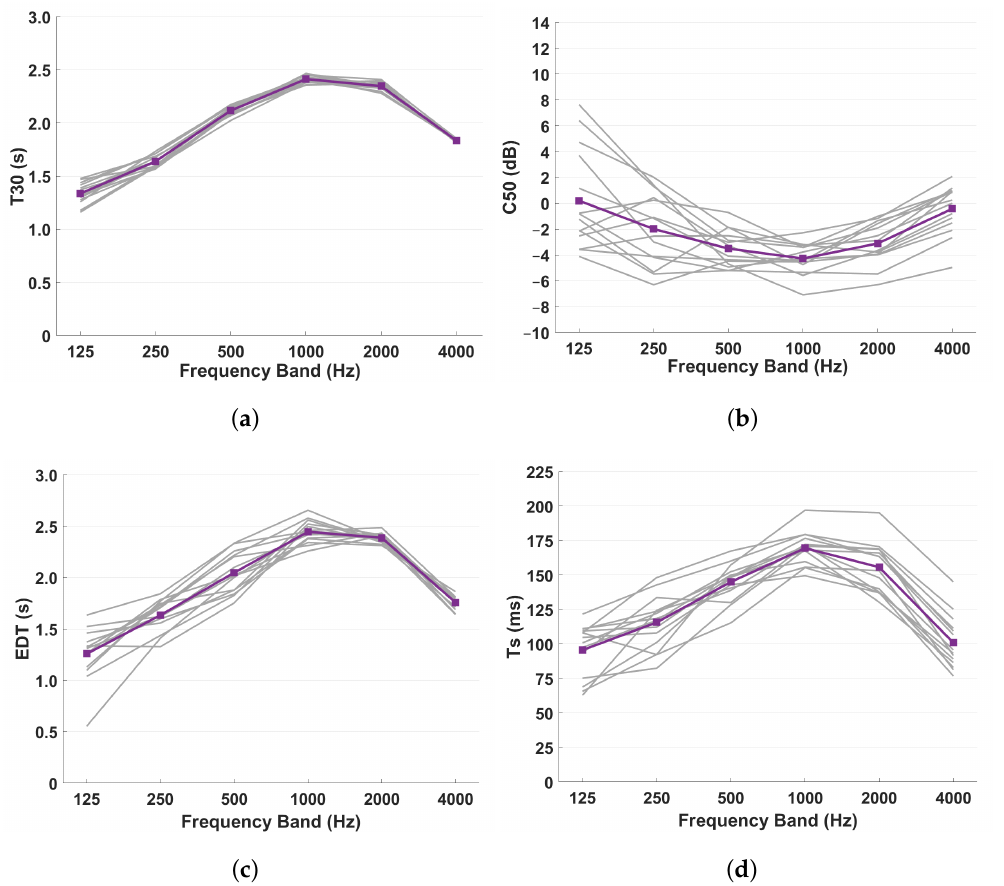
Figure 12. Results of the fourteen individual measured positions in the Convocation House, and the average values across frequency bands for ( a ) T30, ( b ) C50, ( c ) EDT and ( d )